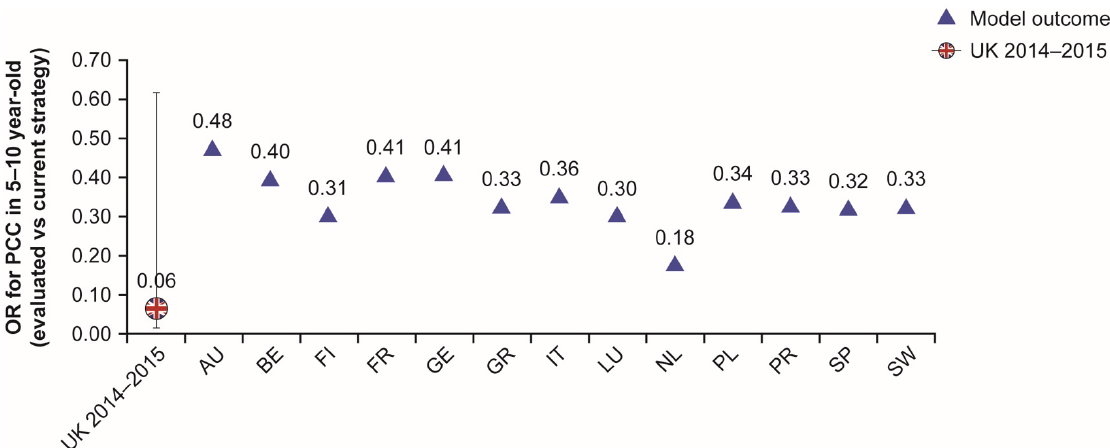
Figure 1. OR for PCC in Target Population (children aged 5–10 years), Model versus UK 2014–2015